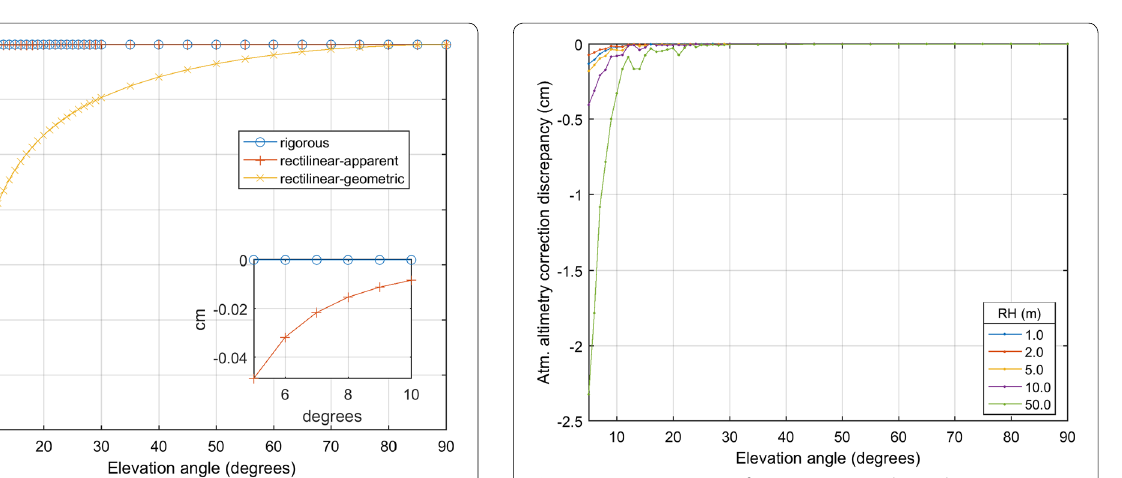
Fig. 5 Discrepancy in interferometric atmospheric altimetry correction between RM and RI formulations as a function of satellite elevation angle (for multiple reflector